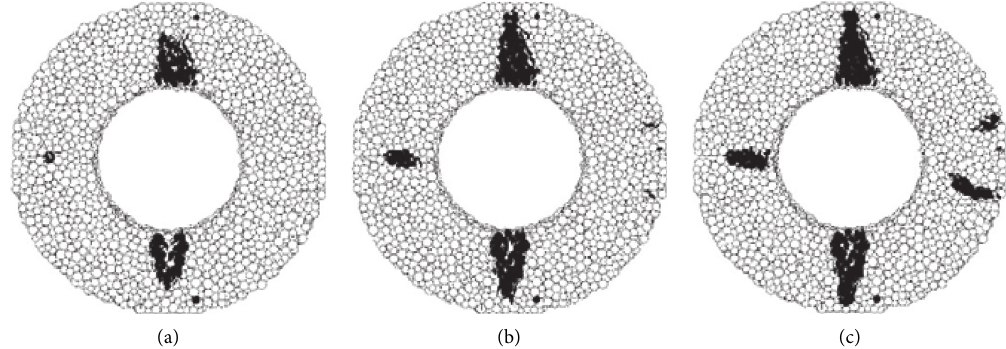
Figure 24: Microcracks distribution in ECFR specimen (A4). (a) Crack initiation. (b) Crack growth. (c) Sample failure.